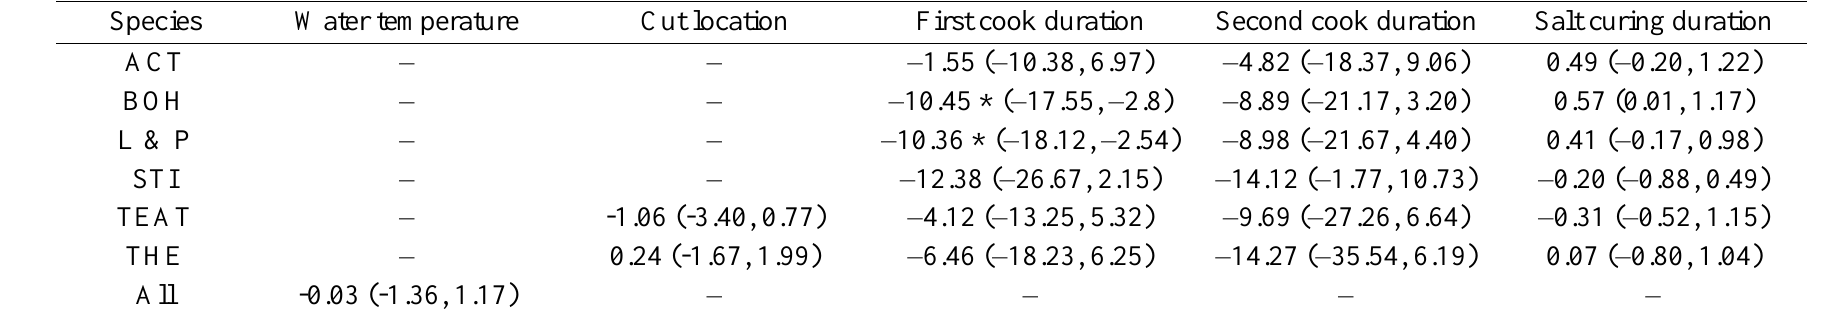
Table A1.3. Summary results of Bayesian hierarchical regressions that tested whether trained and untrained fishers differed in the processing methods employed for six harvested sea cucumber species groups: Actinopyga spp. (ACT), Bohadschia spp. (BOH), lollyfish and pinkfish (L & P), Stichopus spp. (STI), teatfish (TEAT; Holothuria fuscogilva and H. whitmaei ), and Thelenota spp (THE). Values are highest posterior density medians (for water temperature, cut location) and means (for first and second cook duration, salt curing duration) and 95% uncertainty intervals (in